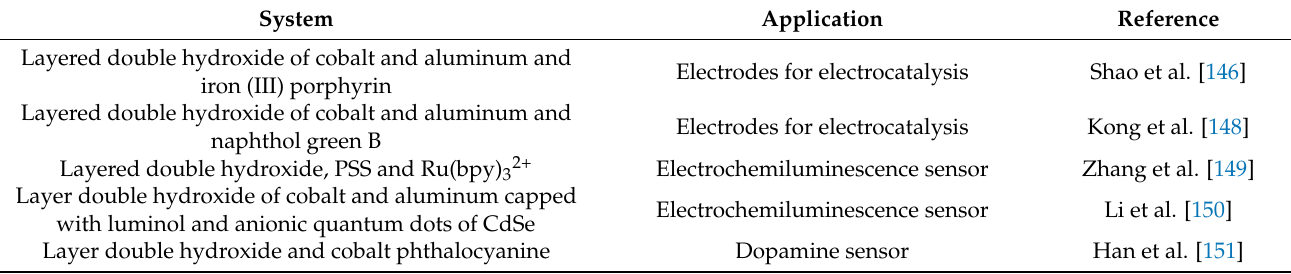
Table 5. Examples of LbL structures containing layered double hydroxides and their potential applications.